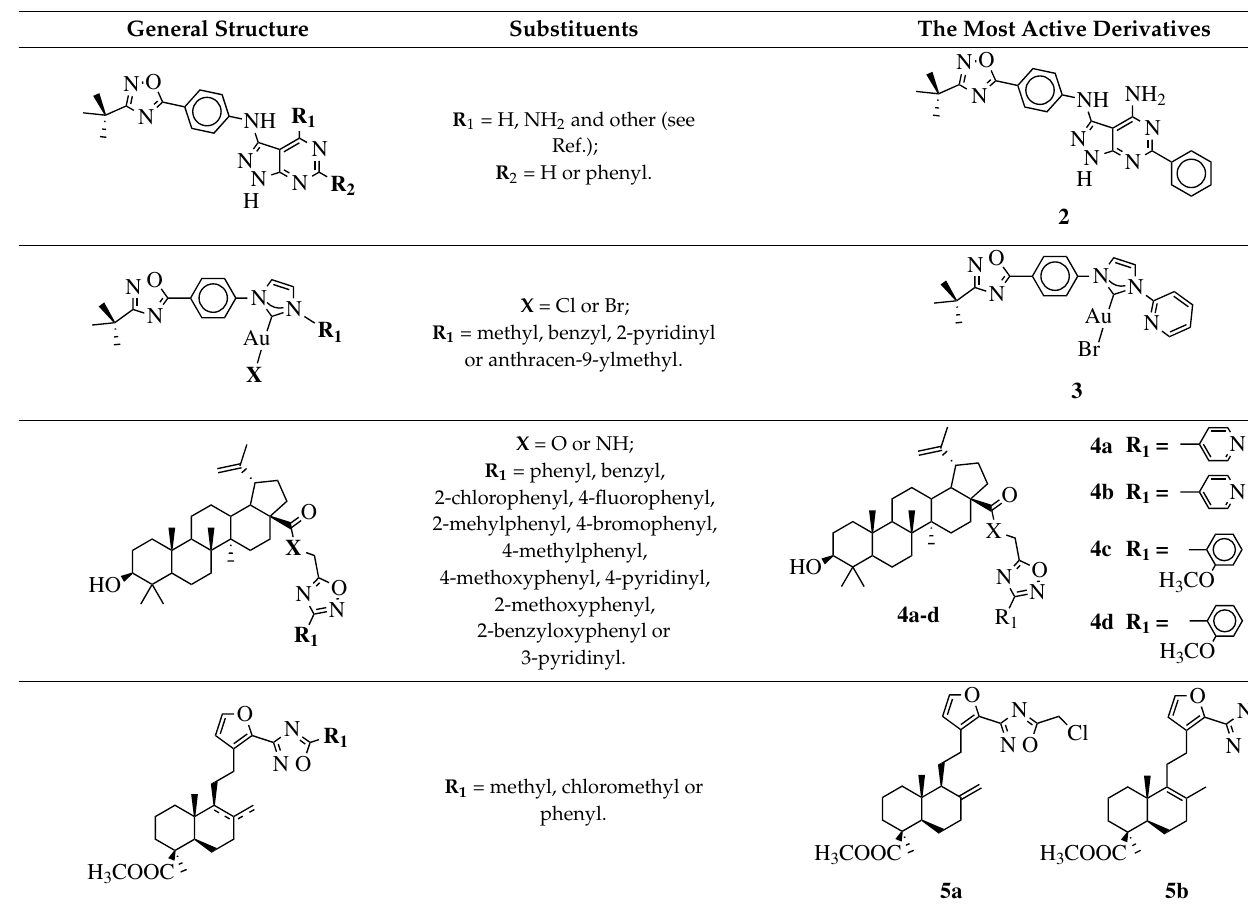
Table 2. 1,2,4-oxadiazole derivatives with antitumor